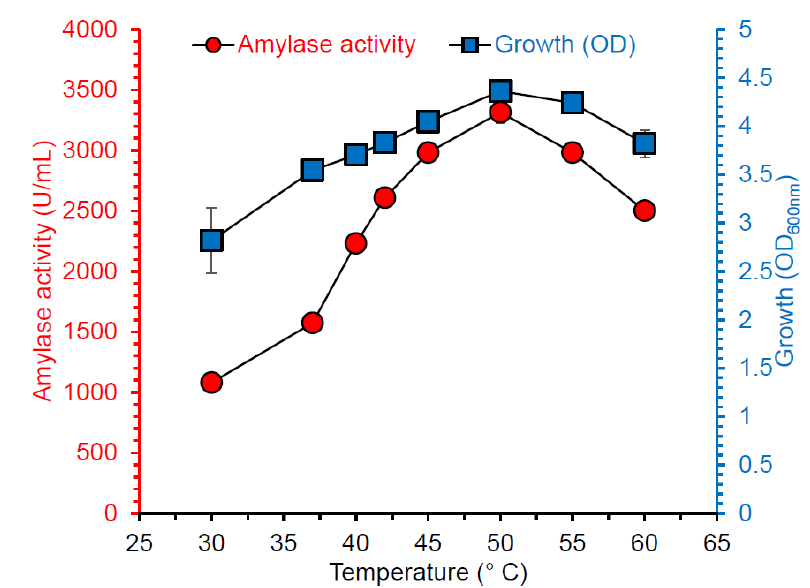
Figure 2. The effect of fermentation temperature on amylase production and cell growth ( Bacillus sp. BCC 021-50) for 36 h. The medium initially contained glucose (20 g/L) and yeast extract (10 g/L) as carbon and nitrogen sources, respectively. The initial pH was 7. The experiments were performed in triplicate and the data presented in the figure are the average of three parallel experiments. Error bars are shown for standard deviation.